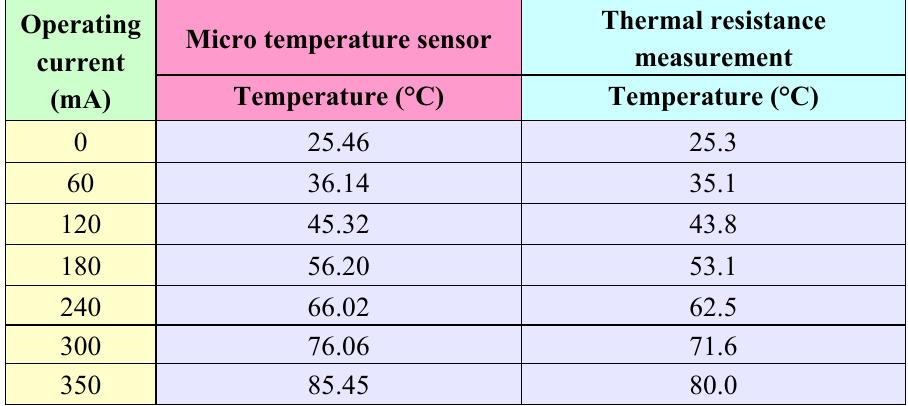
Table 2 . Variation in measurements made using micro temperature sensor and thermal resistance measurement